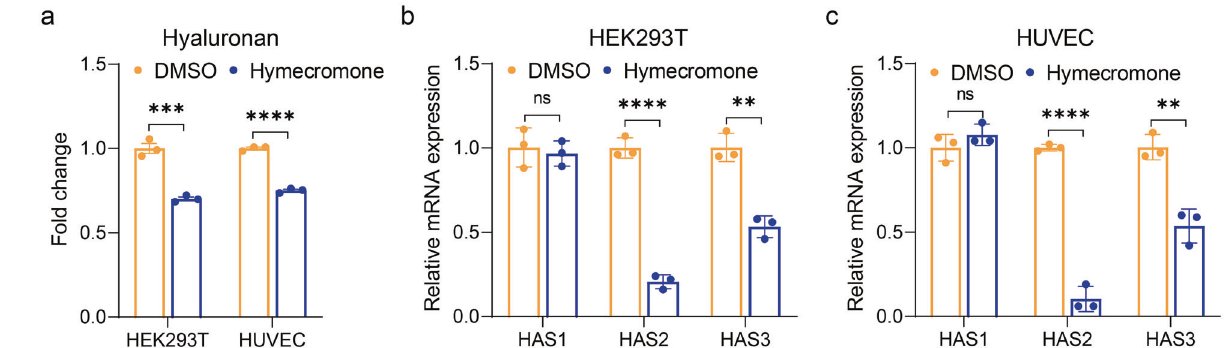
Fig. 5 Hymecromone decreases hyaluronan by downregulating hyaluronic acid synthases. a ELISA detected the hyaluronic acid level of culture medium in HEK293T and HUVEC treated with DMSO or hymecromone (200 μ g/mL). The fold change of hyaluronic acid was normalized to DMSO. b RT-qPCR evaluated the mRNA levels of HAS1 , HAS2 , and HAS3 in HEK293T treated with DMSO or hymecromone (200 μ g/mL). c RT- qPCR evaluated the mRNA levels of HAS1 , HAS2 , and HAS3 in HUVEC treated with DMSO or hymecromone (200 μ g/mL). All experiments were repeated independently in triplicate. Data are presented by mean ± SD. The signi fi cant difference was con fi rmed by unpaired t test. * P < 0.05; ** P < 0.01; *** P < 0.001; **** P < 0.0001; ns, not signi fi